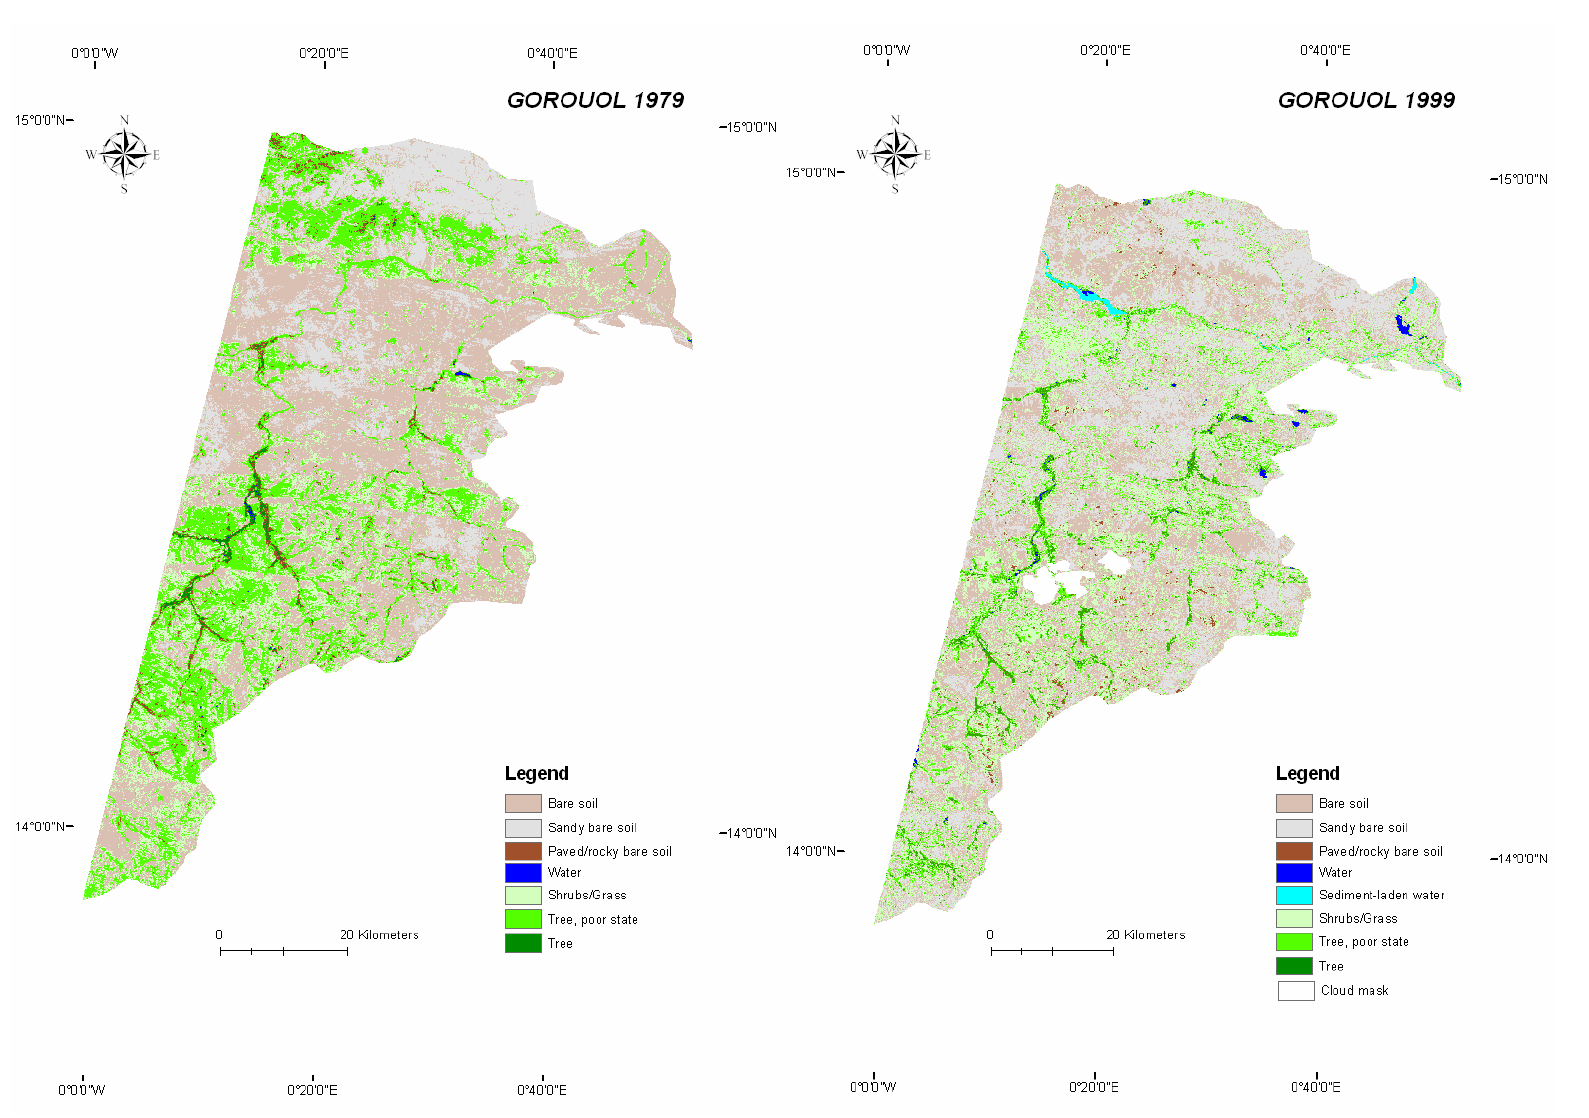
Figure 6. Land cover changes in the Gorouol basin between 1979 and 1999, using Landsat